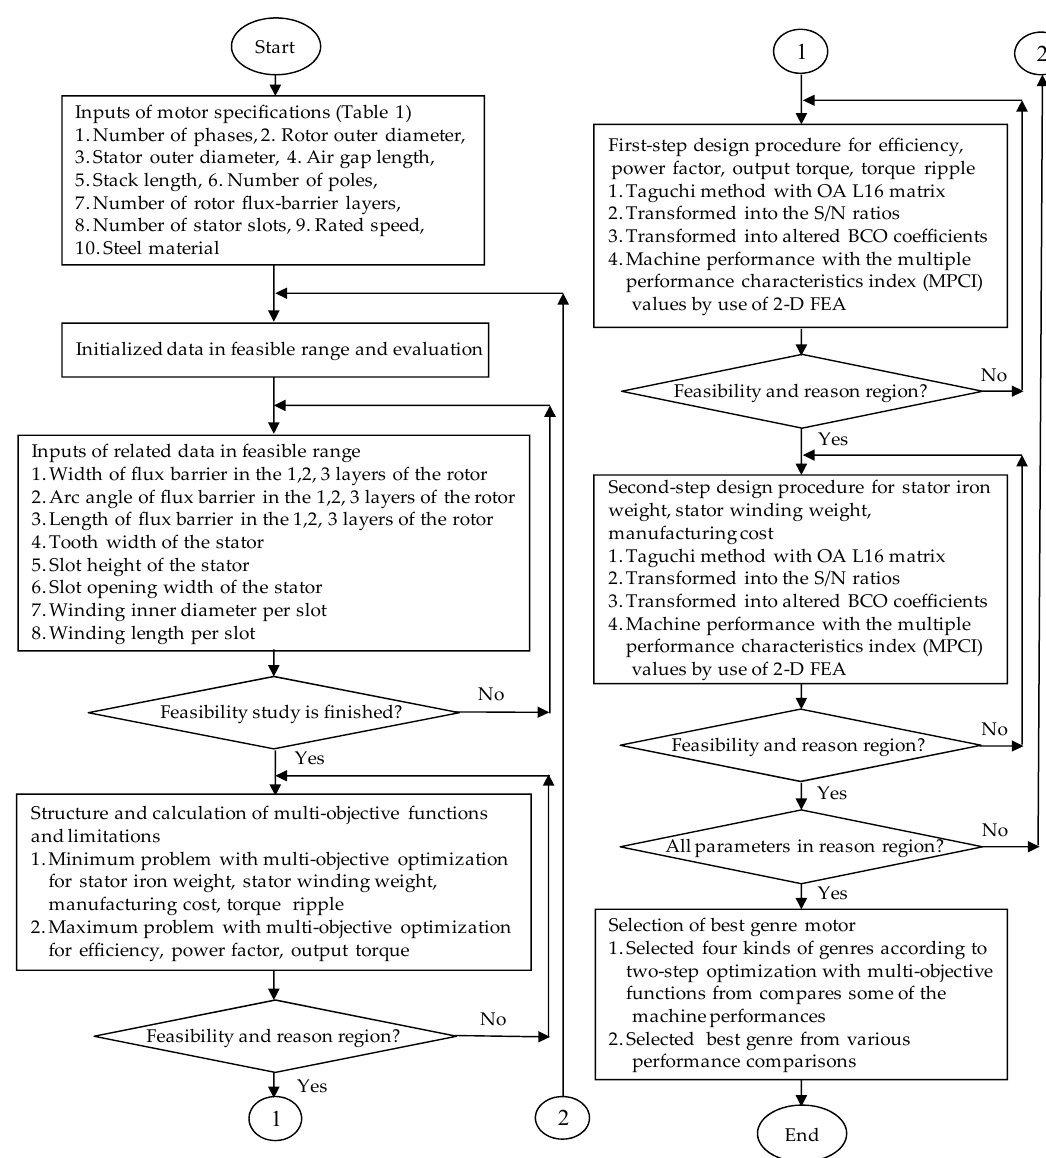
Figure 4. Flowchart diagram of two-step optimal design procedures with multi-objective functions.